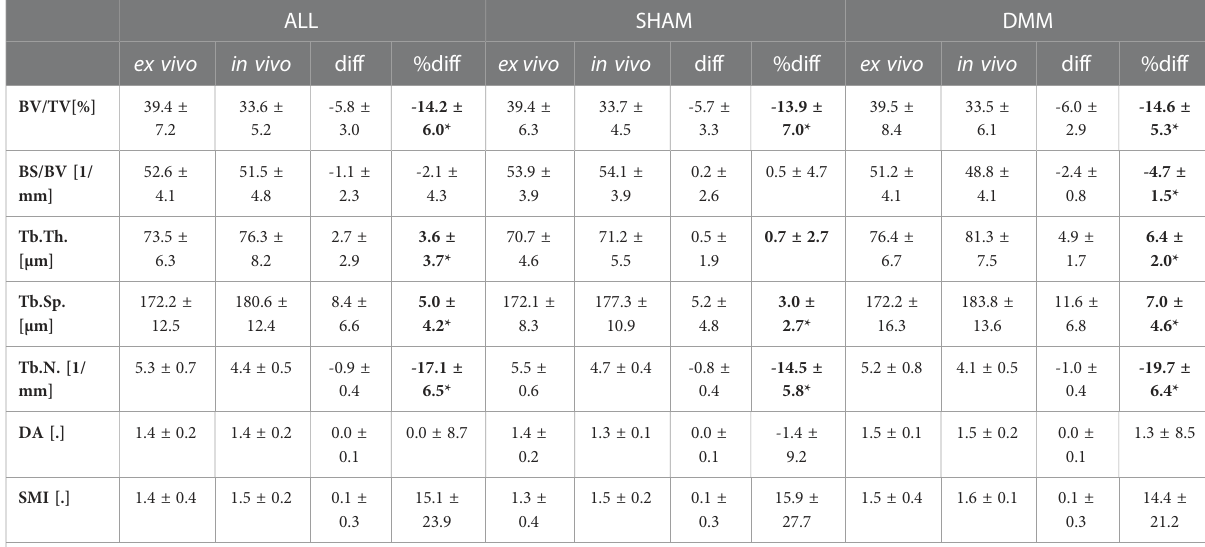
TABLE 2 Trabecular parameters measured in the medial compartment with in vivo and ex vivo microCT for the pooled (ALL) data and for each group (SHAM or DMM). ALL SHAM DMM ex vivo in vivo